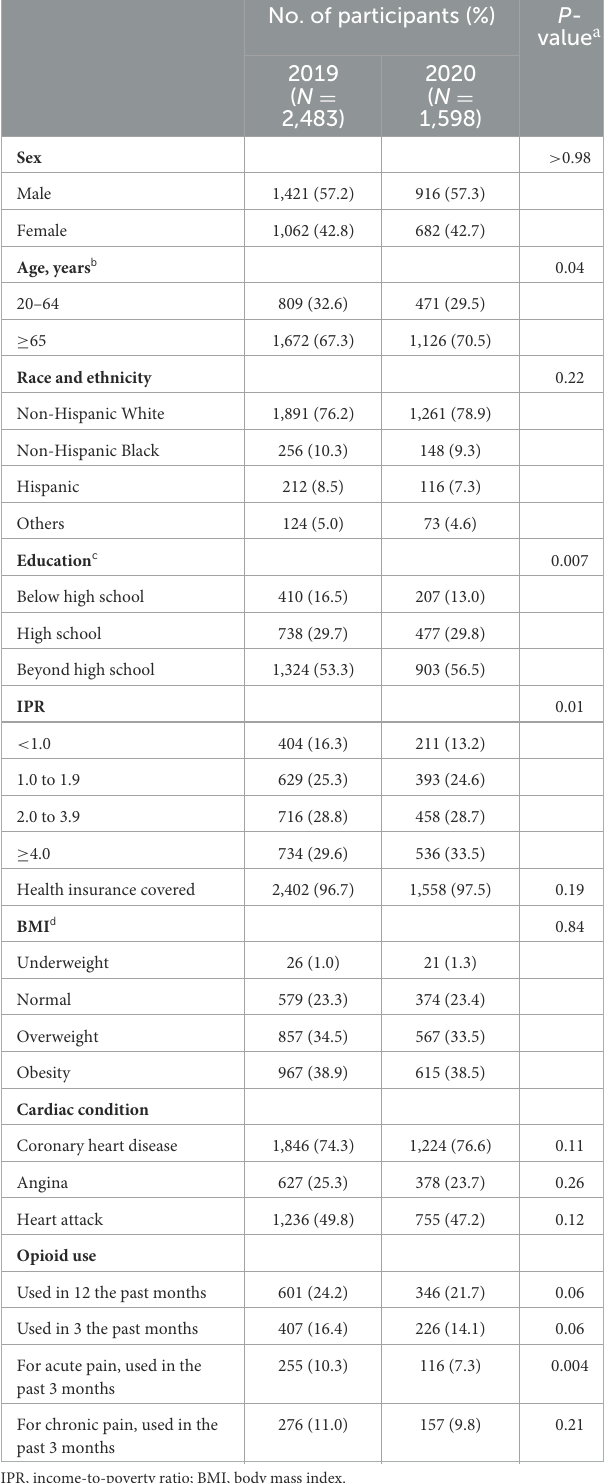
TABLE 1 Characteristics of participants with cardiac conditions in NHIS in 2019 and